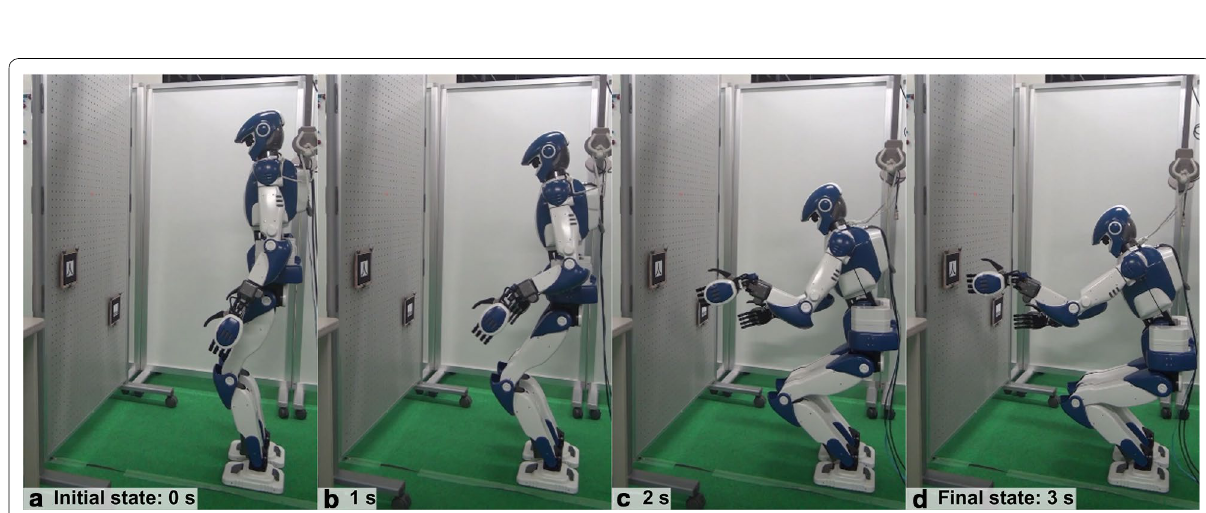
Fig. 14 The proposed method generates whole-body motion to make the HRP-4 reach with both hands the target positions indicated with AR markers. By managing the CoM in the center of the foot’s soles, the robot can keep its balance while hunkering down ( a initial state, b and c inter- mediate states, and d final